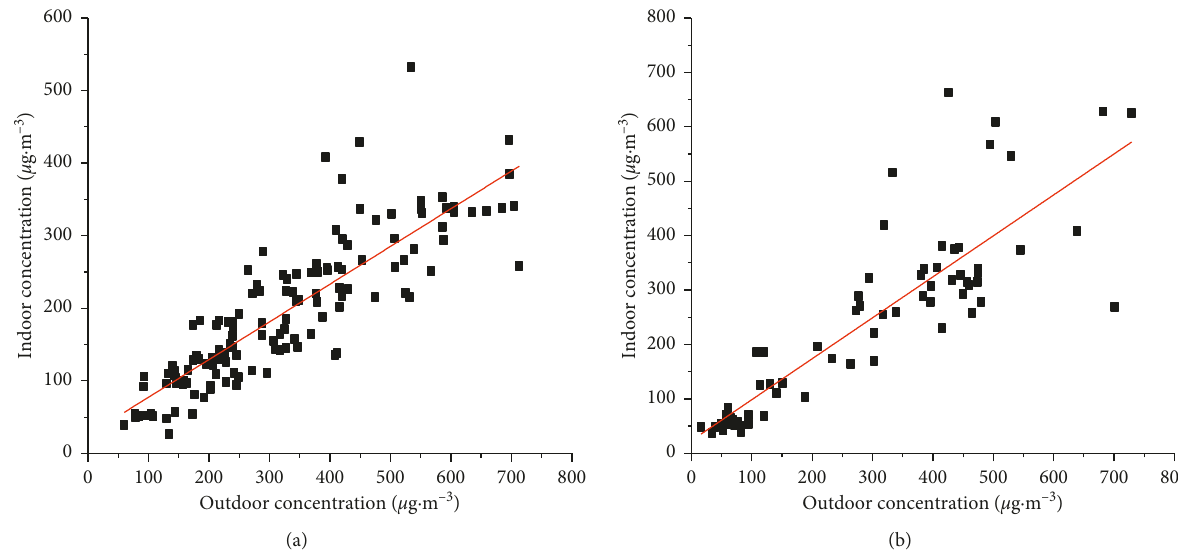
Figure 9: The relationships between the indoor PM10 concentrations and the outdoor PM10 concentrations: (a) summer; (b) winter.